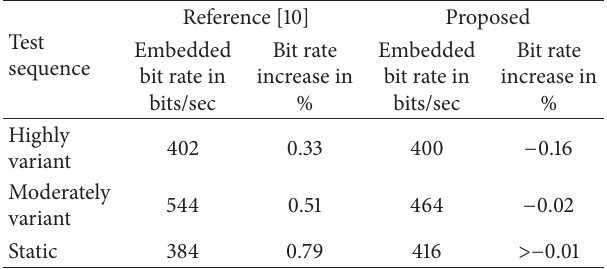
Table 2: Embedded bit rate in bits/sec for the technique proposed and that of